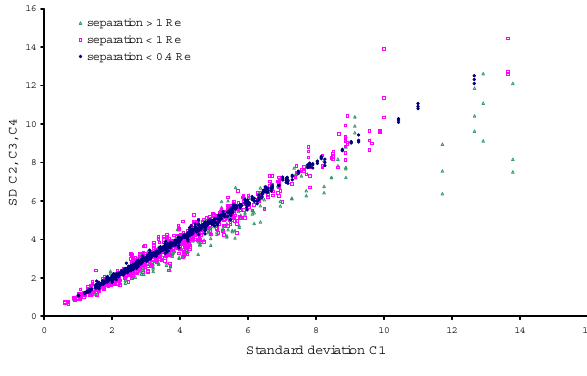
Fig. 11. Cross-correlation coefficients between two magnetosheath points as a function of the cross-correlation function between IMF (Wind) and magnetosheath magnetic field. See the text for a de- tailed description.